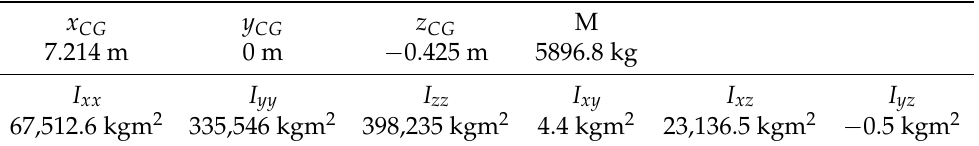
Table 7. Center of mass, mass, and inertia tensor of the complete aircraft [62].